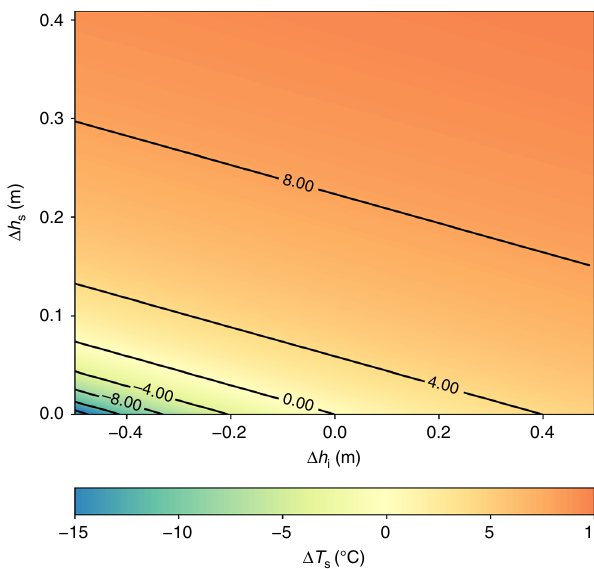
Fig. 4 The dependency of the surface temperature bias on ice and snow thickness errors. The bias Δ T is induced by the errors of ice Δ h s thickness Δ h . Here, we assume a simulated 1.5 m thick sea-ice without a s ¼ 1 : 5 m and h ¼ 0 snow layer, i.e., h i s